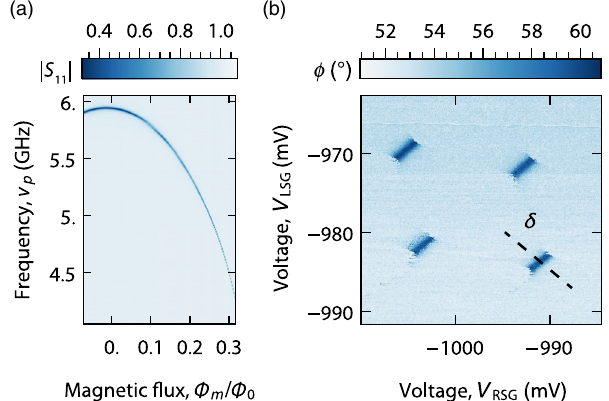
FIG. 2. Characterization of the SQUID array resonator and double quantum dot. (a) Reflectance spectrum j S 11 j of the resonator as a function of probe frequency ν = Φ 0 . (b) Hexagonal charge stability diagram magnetic flux Φ m of the DQD detected in the phase ϕ of the microwave tone at frequency ν reflected off the resonator close to its resonance p frequency ν as a function of the applied side gate voltages V r and V LSG